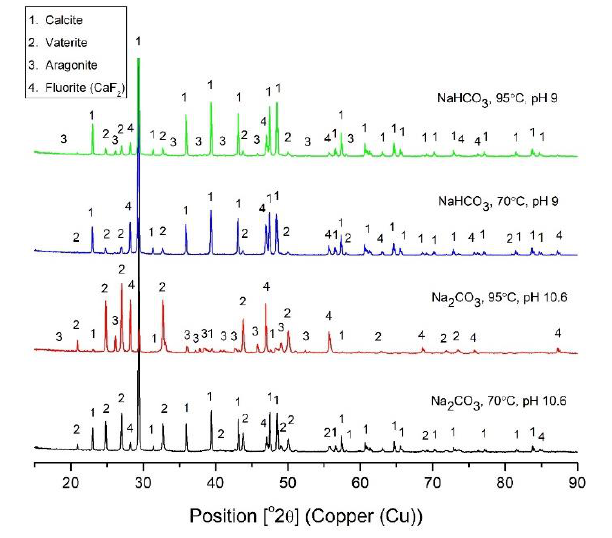
Figure 3. XRD diffractogram of residues after dissolution reaction of 300 mg/L CaF 2 for 480 min. Figure 3. XRD di ff ractogram of residues after dissolution reaction of 300 mg / L CaF 2 for 480 min.